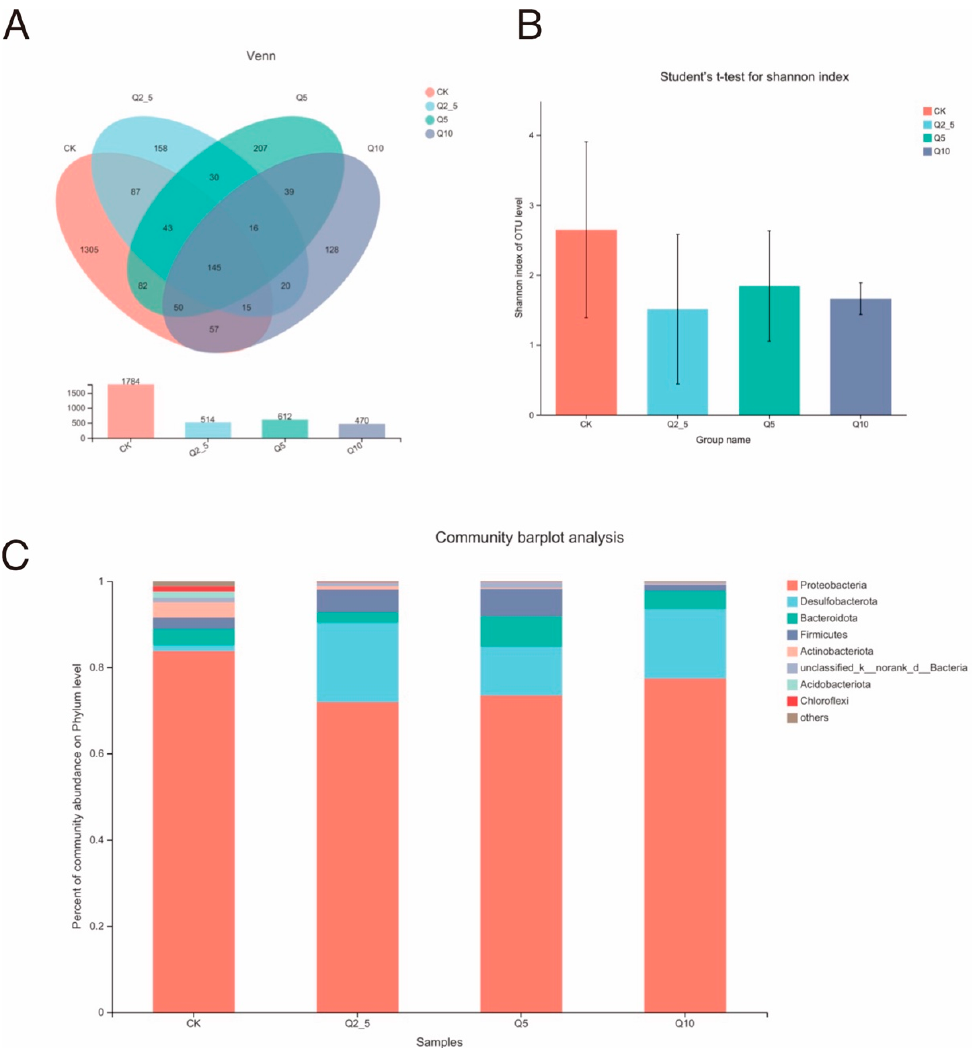
Figure 1. ( A ) Venn diagram showing common or endemic species. Different colors represent different groups. The numbers in the overlapping part represent the number of species common to multiple groupings and the numbers in the non-overlapping part represent the number of species unique to the corresponding grouping. ( B ) α -Diversity analysis of the gut microbial community differences between the control group and the three experimental groups. The values are presented as Shannon index values. A one-way ANOVA with Student’s t -test were used to determine significant differences between the control and the three experimental groups: p < 0.05 was considered statistically significant (* p < 0.05). ( C ) Histogram of the relative distribution of each group at the phylum level (species in the top nine in terms of relative abundance). The ordinate indicates the ratio of the number of sequences annotated at the phylum level compared to the total annotated data. The color order from bottom to top corresponds to the color order of the legend on the right.